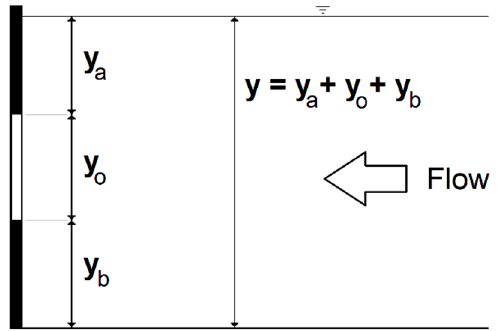
Figure 4. Breakdown of flow-depth components y b (the flow-depth below the porous section), y o (flow-depth in contact with the porous section), and y a (the flow-depth above the porous section).